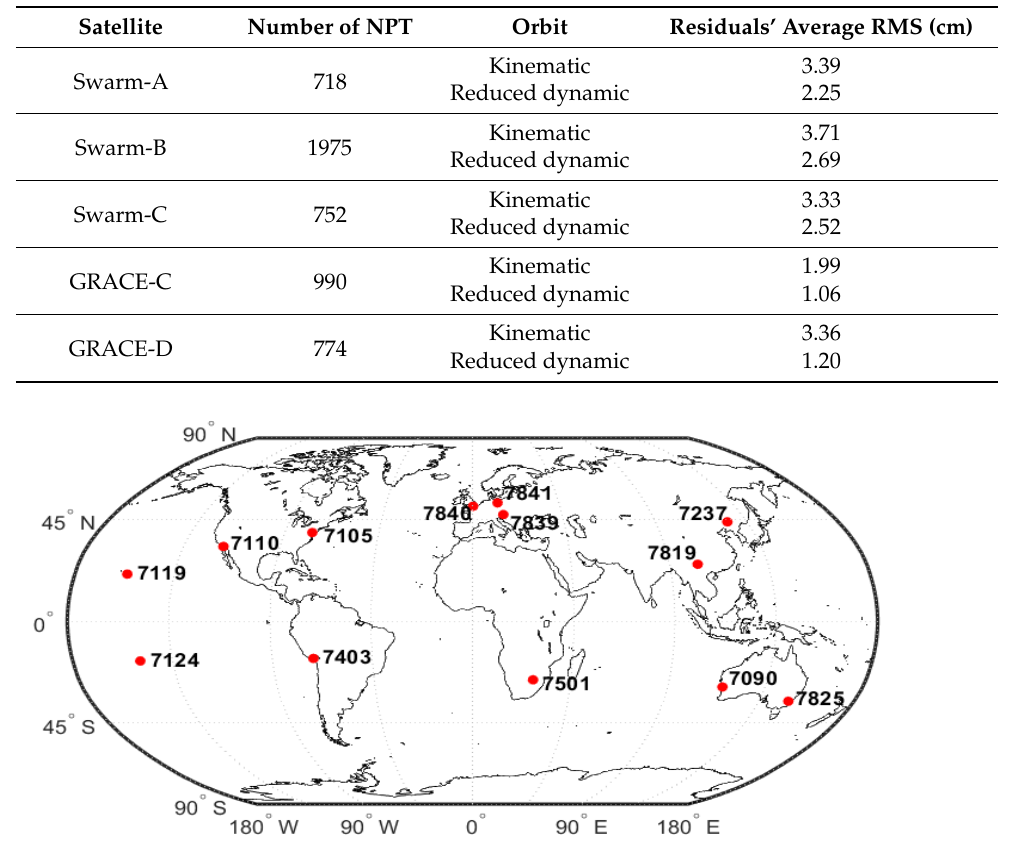
Figure 4. The distribution of the selected 13 SLR stations.